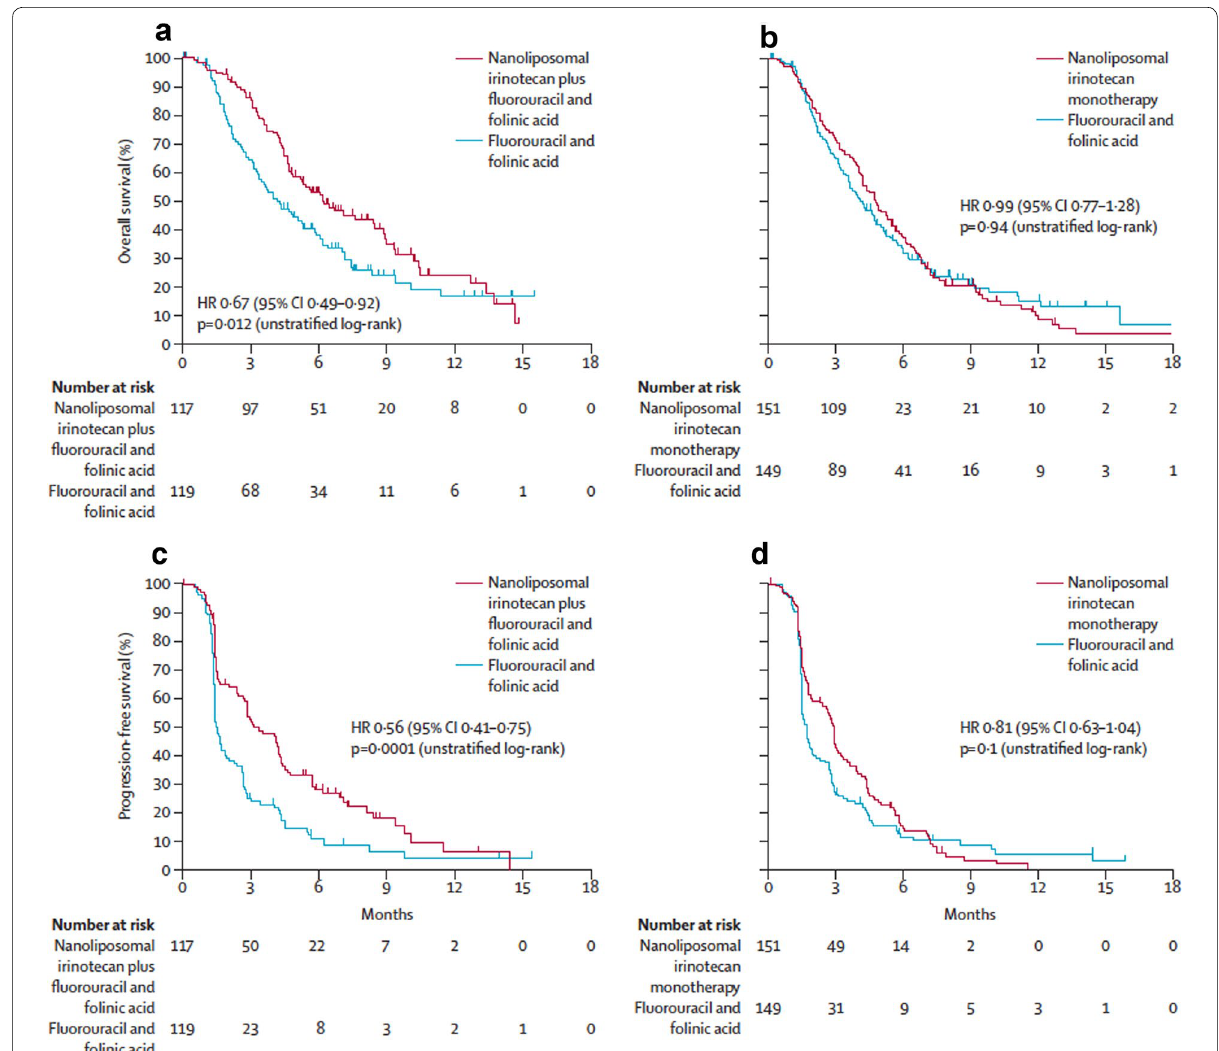
Fig. 9 Kaplan–Meier survival analyses for phase III trial. HR hazard ratio. a Overall survival with nanoliposomal irinotecan plus fluorouracil and folinic acid versus fluorouracil and folinic acid. b Overall survival with nanoliposomal irinotecan monotherapy versus fluorouracil and folinic acid. c Progression‑free survival with nanoliposomal irinotecan plus fluorouracil and folinic acid versus fluorouracil and folinic acid. d Progression‑free survival with nanoliposomal irinotecan monotherapy versus fluorouracil and folinic acid (Reproduced with permission from